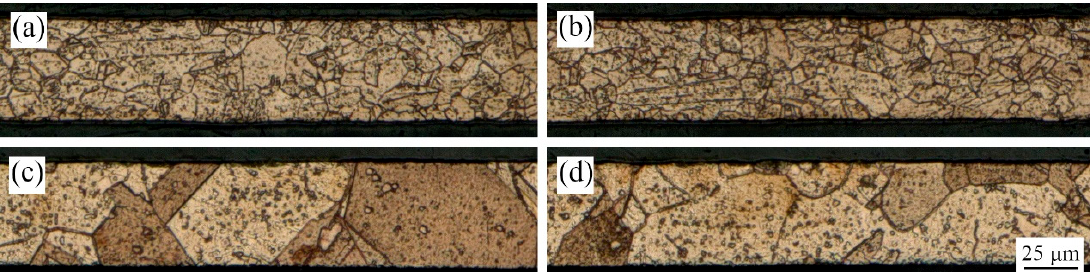
Figure 1. Schematic of microscale laser dynamic flexible bulging ( μ LDFB). ( a ) LPS; ( b ) μ LDFB; ( c )